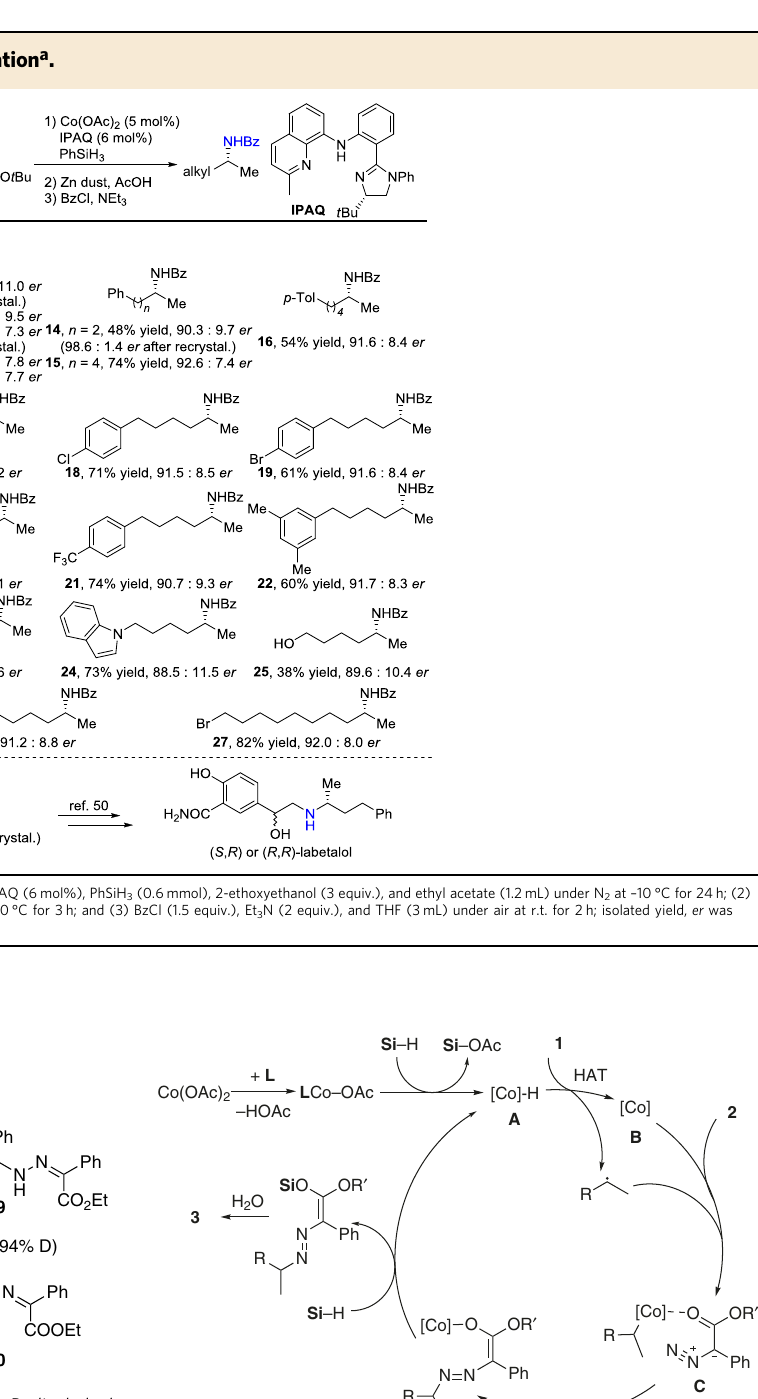
Table 3 Reaction scope of asymmetric hydroamination a .